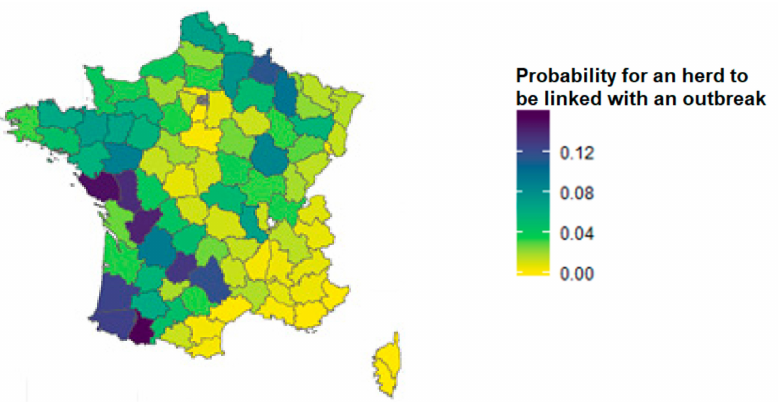
Figure 2. Mean probability of a herd having a downstream epidemiological link to a TB outbreak used in the scenario